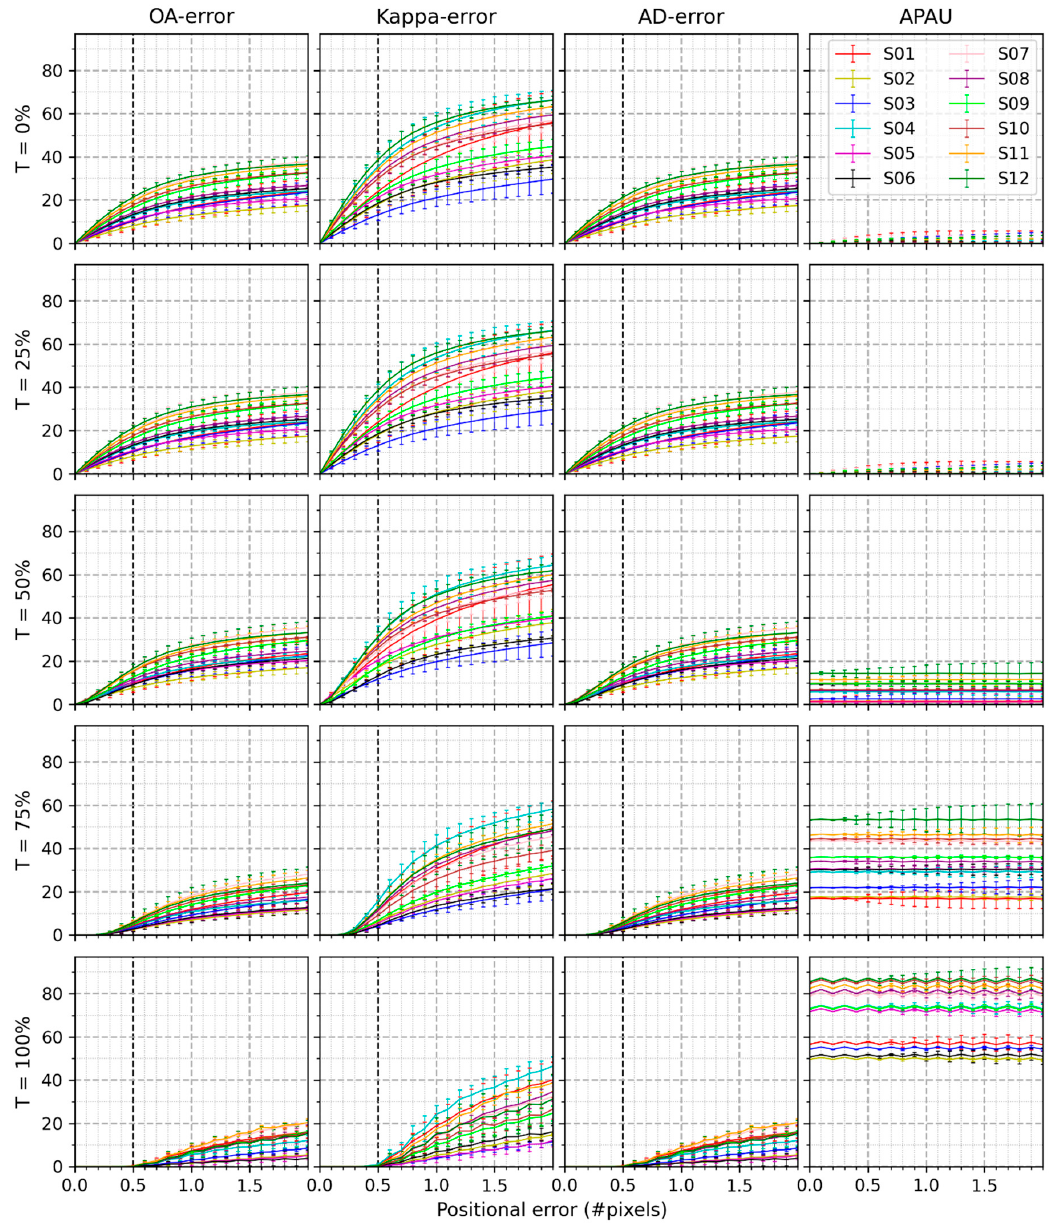
Figure 5. Mean and standard deviation of OA − error , Kappa − error , AD − error , and APAU of four spatial scales at different study sites where the classification scheme consists of 8 classes.